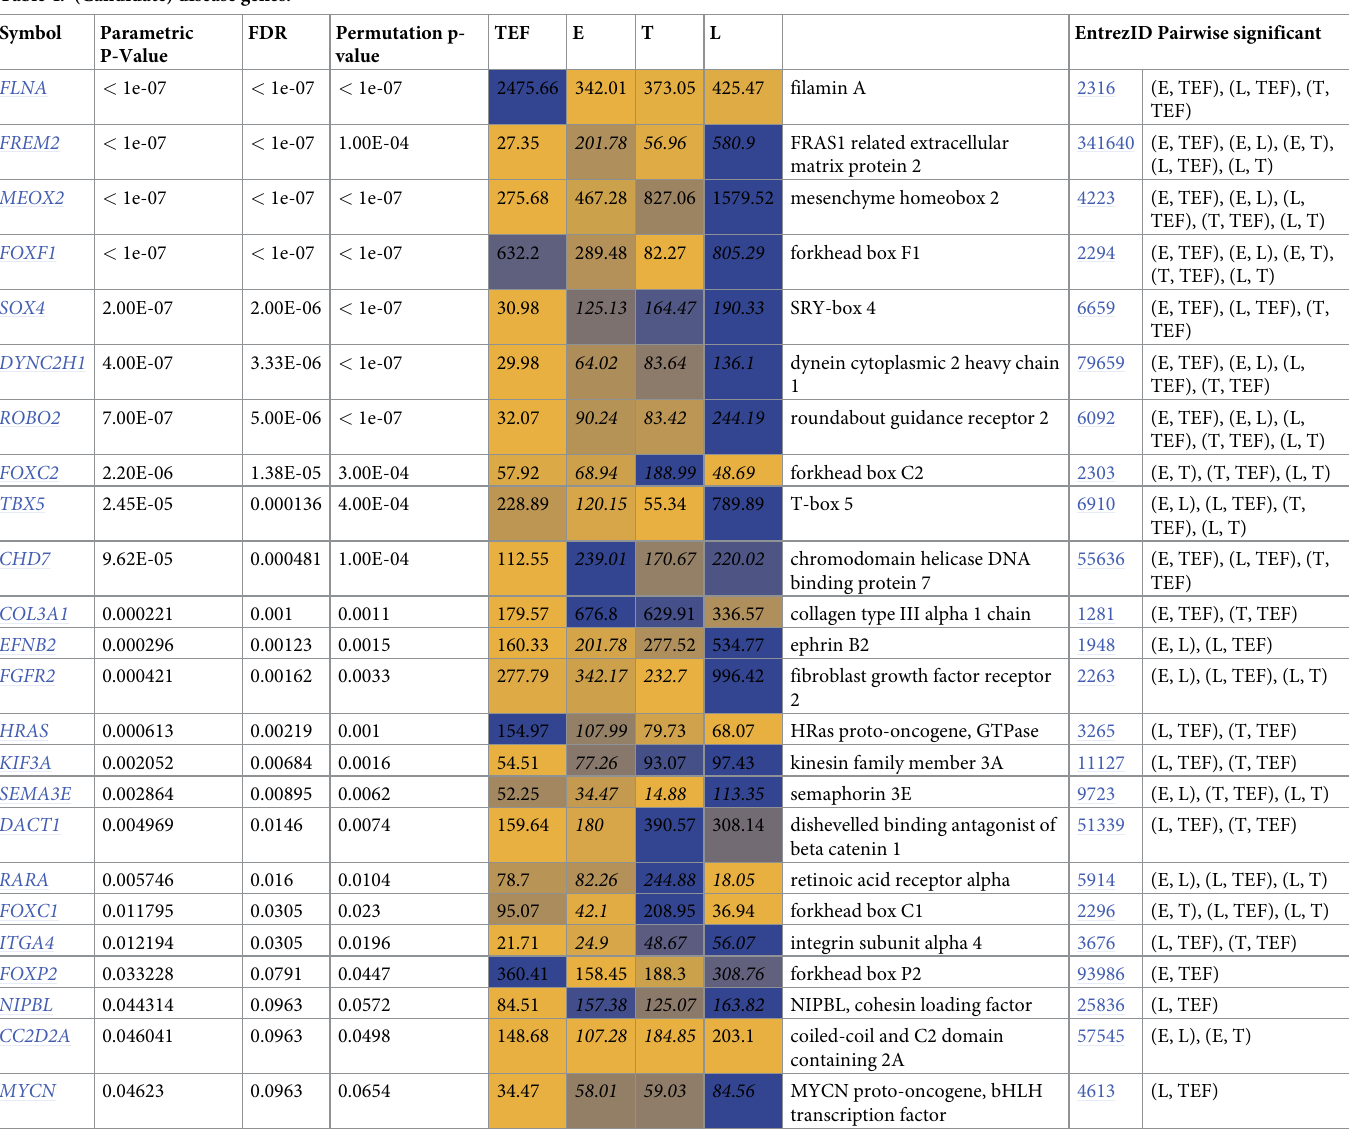
Table 4. (Candidate) disease genes. Symbol Parametric